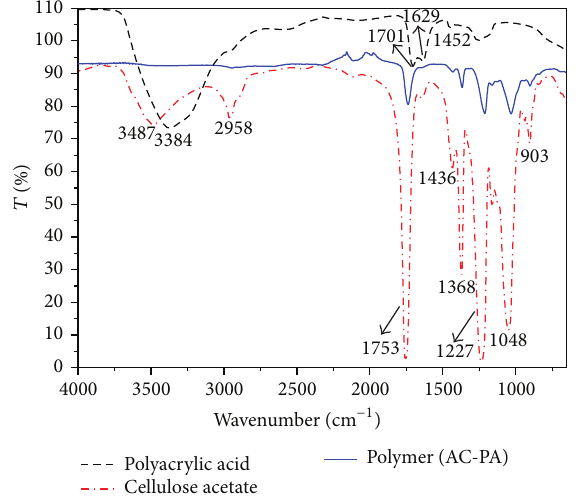
Figure 2: Infrared spectra of the different polymers.